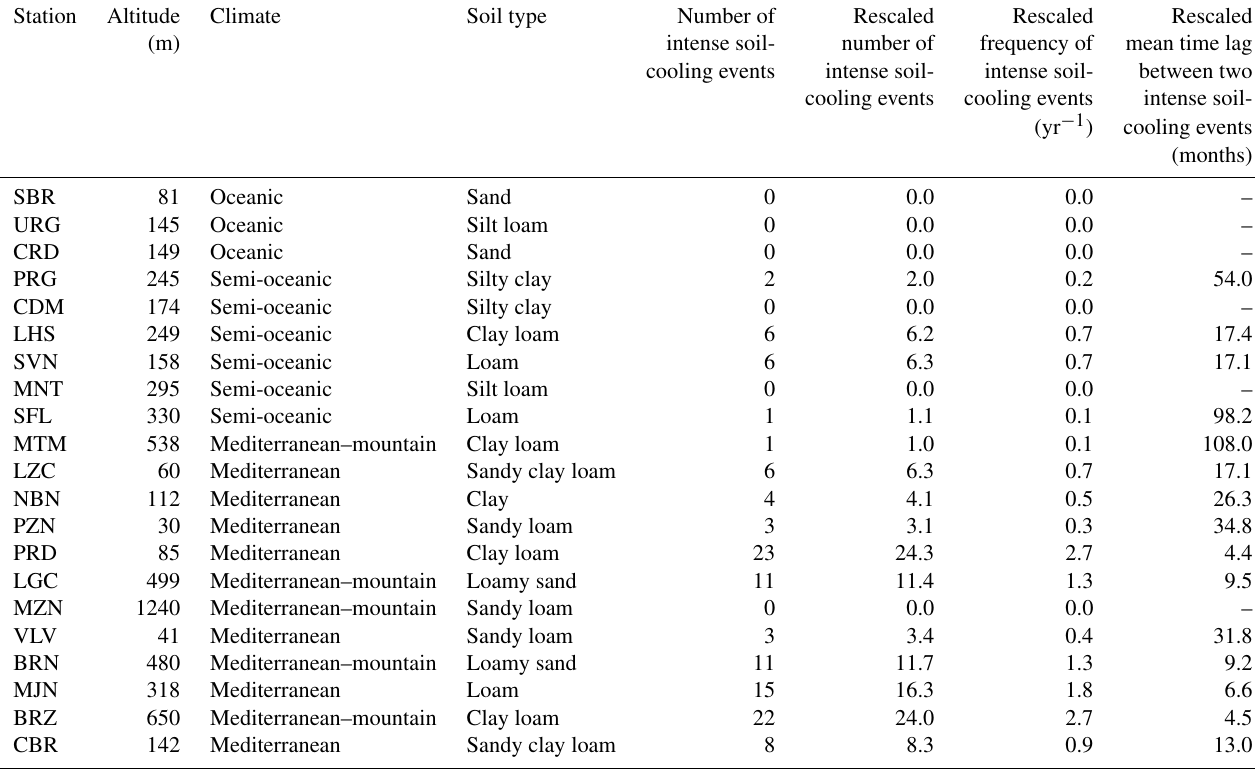
Table 1. The environment characteristics for the 21 stations of the SMOSMANIA network and the frequency of intense soil cooling during marked rainfall events from 2008 to 2016. The number of intense soil-cooling rains, the frequency, and the mean time lag between two intense soil-cooling rains are rescaled according to the fraction of missing data across seasons (see Table S1). Stations are listed from (top) west to (bottom)